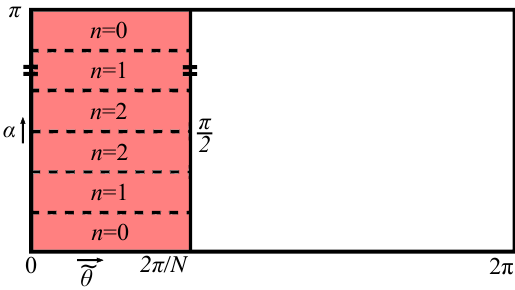
Figure 2 . The Penrose diagram for the dS 2 kinematic space for pure AdS 3 is shown as the full rectangular region, with (cid:18) = (cid:18) +2 (cid:25) . For the conical defect case the di(cid:11)erential entropy de(cid:12)nition of kinematic space produces a vertical strip subregion. The same angular identi(cid:12)cation which gives the conical defect from AdS 3 also gives the kinematic space. N = 3 is shown for illustration throughout most of this